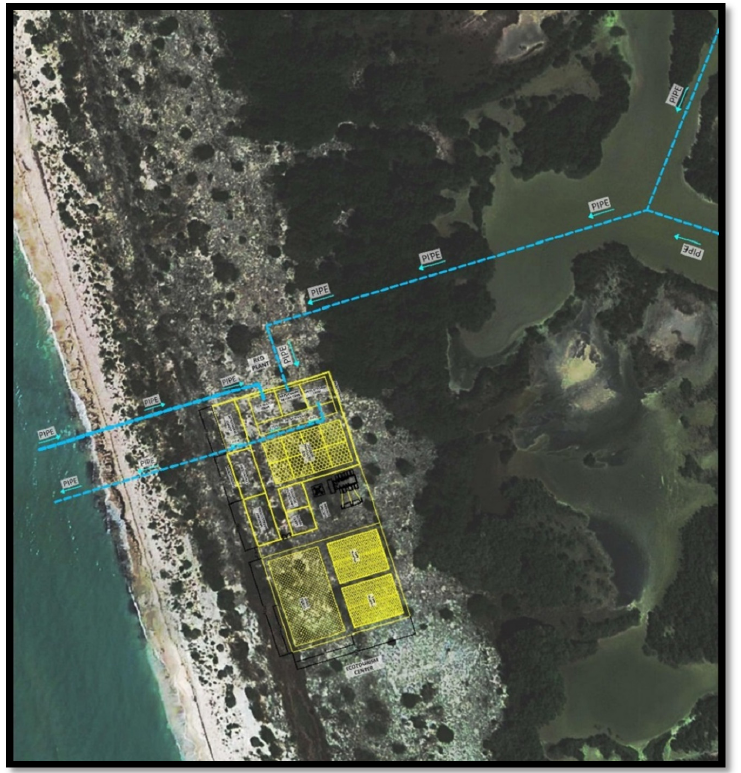
Figure 4. Potential location of the RED pilot power plant; the dotted lines indicate the pipelines.